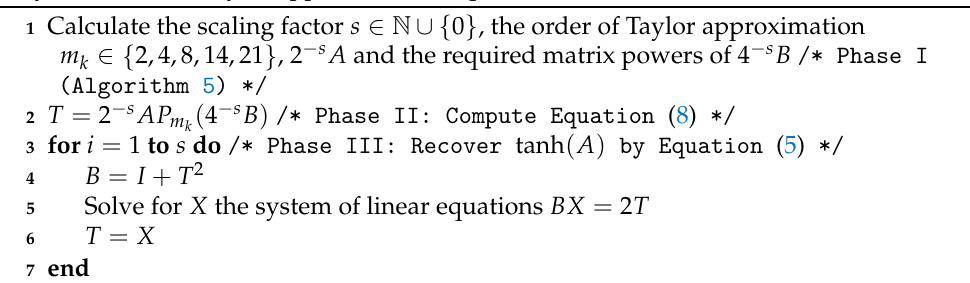
Algorithm 3: Given a matrix A ∈ C n × n , this algorithm computes T = tanh ( A ) by means of the Taylor approximation Equation (8) and the Sastre